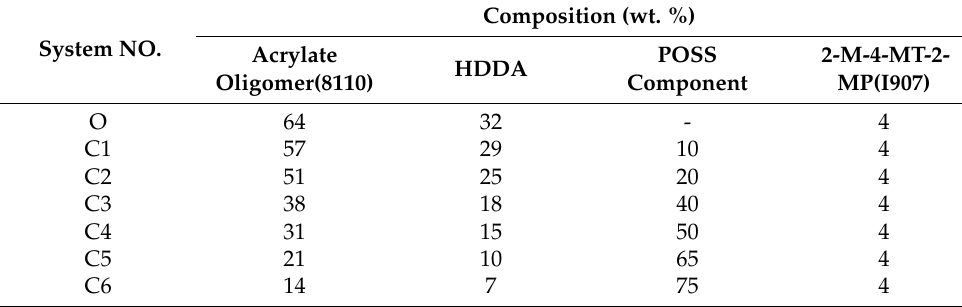
Table 1. The composition of mixture suspension